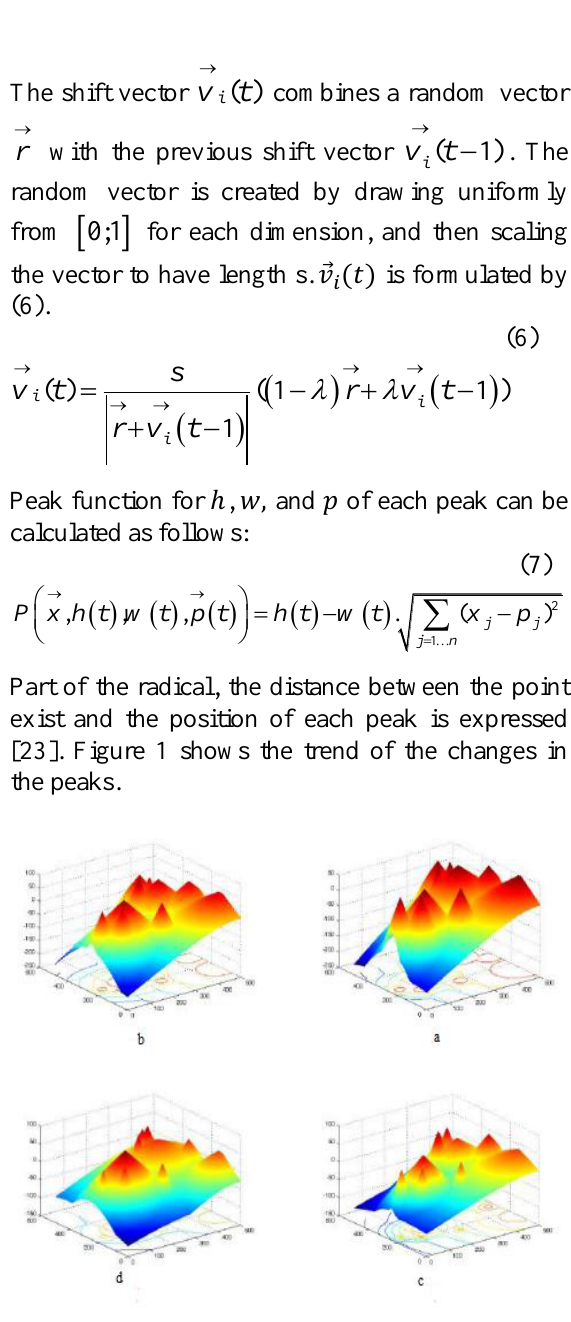
Figure 1. Trend of changes in peaks in